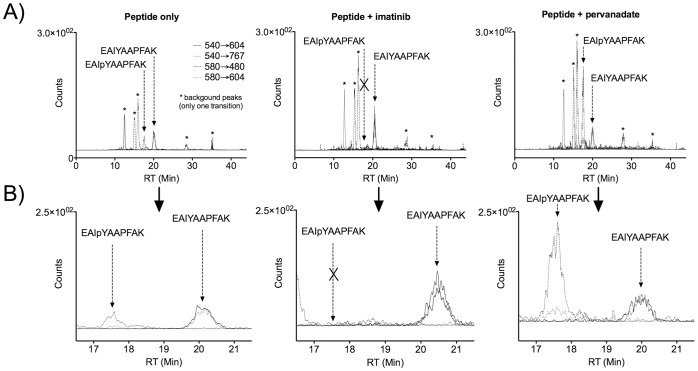
Representative extracted transition chromatograms for each treatment condition.Full chromatograms are shown in row (A). Expanded chromatograms for the region in which EAIYAAPFAK and EAIpYAAPFAK are expected to elute (based on the calibration curve) are shown in row (B), and show that the relevant peaks had signal for both transitions from each analyte.